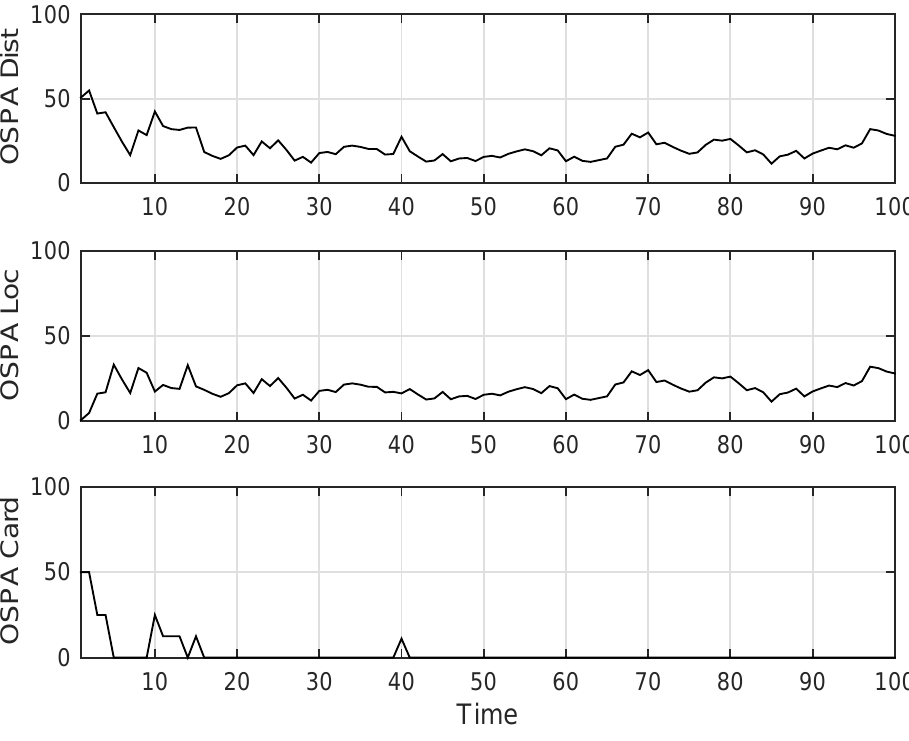
Figure 15. The OSPA distance by GLMB filter for experiment 2.